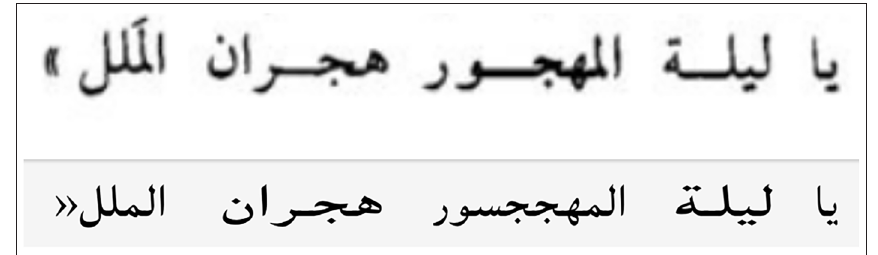
Figure 21: Read letter ‘sin’ into word due to kash ī da/tatw ī l (elongation).